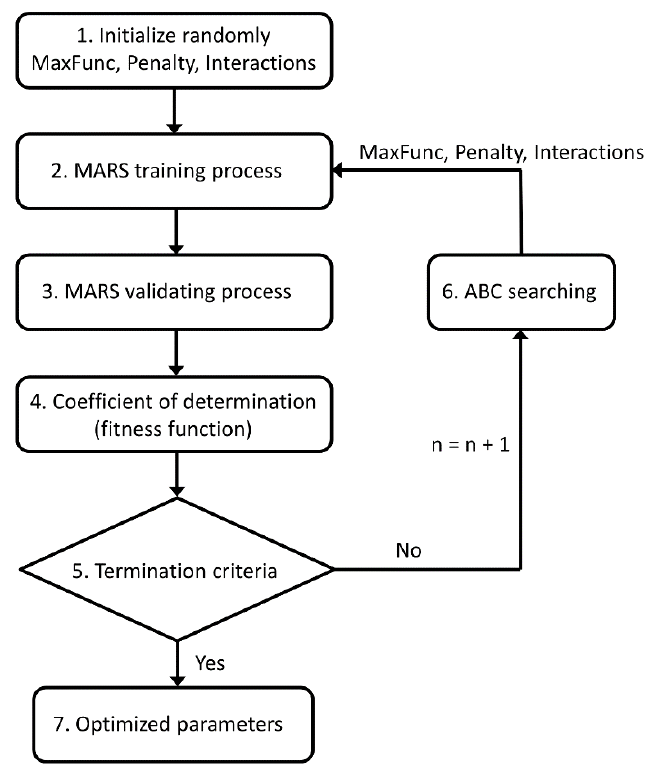
Figure 6. Flowchart of the new hybrid ABC–MARS-based model.